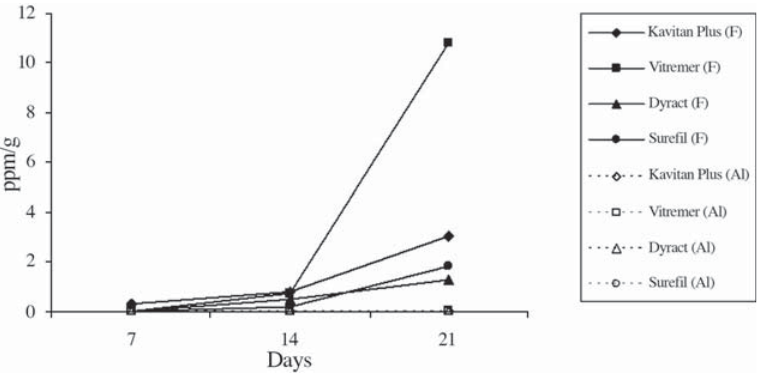
Figure 5- (cid:4)(cid:31)(cid:27)(cid:17)(cid:27)(cid:6)(cid:7)(cid:12)(cid:9)!(cid:14)(cid:4)"(cid:27)(cid:18)(cid:24)(cid:9)(cid:16)(cid:14)(cid:4)(cid:7)(cid:10)(cid:16)(cid:4)(cid:7)(cid:6)(cid:27)(cid:17)(cid:9)(cid:10)(cid:27)(cid:17)(cid:4)(cid:24)(cid:14)(cid:6)(cid:14)(cid:7)(cid:21)(cid:14)(cid:16)(cid:4)(cid:29)(cid:24)(cid:18)(cid:17)(cid:4)(cid:14)(cid:7)(cid:8)(cid:13)(cid:4)(cid:17)(cid:7)(cid:12)(cid:14)(cid:24)(cid:9)(cid:7)(cid:6)(cid:4)(cid:9)(cid:10)(cid:4)(cid:7)(cid:24)(cid:12)(cid:9)(cid:15)(cid:8)(cid:9)(cid:7)(cid:6)(cid:4)(cid:21)(cid:7)(cid:6)(cid:9)!(cid:7)(cid:4)(cid:7)(cid:29)(cid:12)(cid:14)(cid:24)(cid:4)(cid:16)(cid:7)(cid:3)(cid:4)(cid:30)